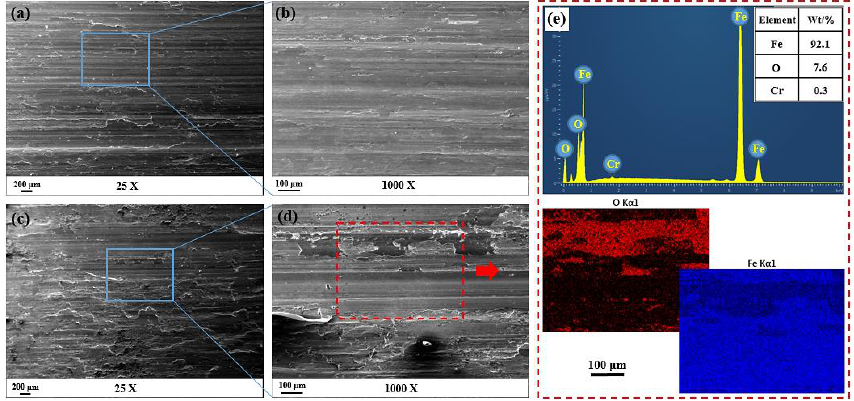
Figure 12. The worn surface morphologies of the counterpart ring under different load: ( a , b ) 300 N; ( c – e ) 900 N.